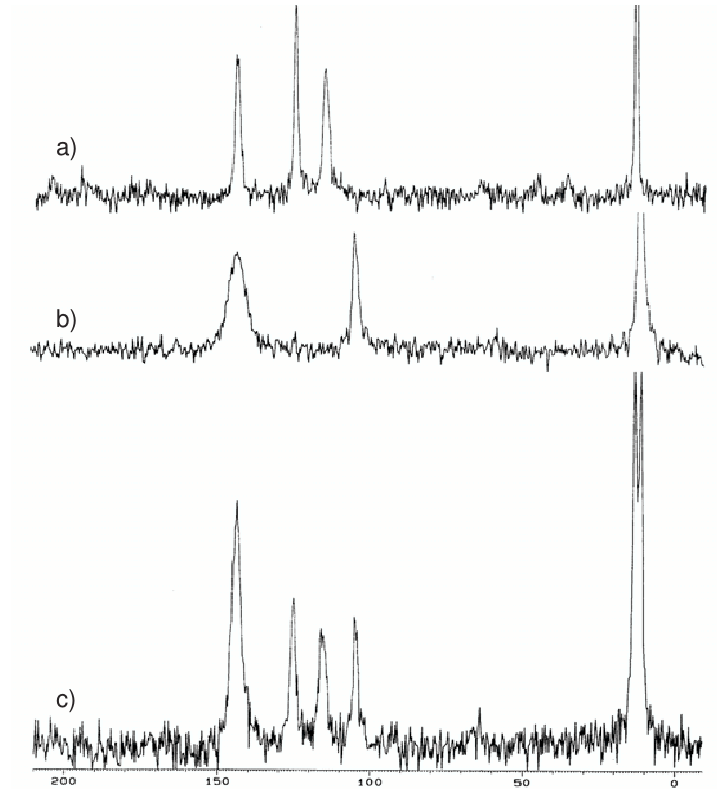
Fig. 2 13 C CPMAS NMR spectra of a) 2-methylimidazole ( 3 ), b) 3,5-dimethylpyrazole ( 1 ), c) A 1:1 mixture of 1 + 3